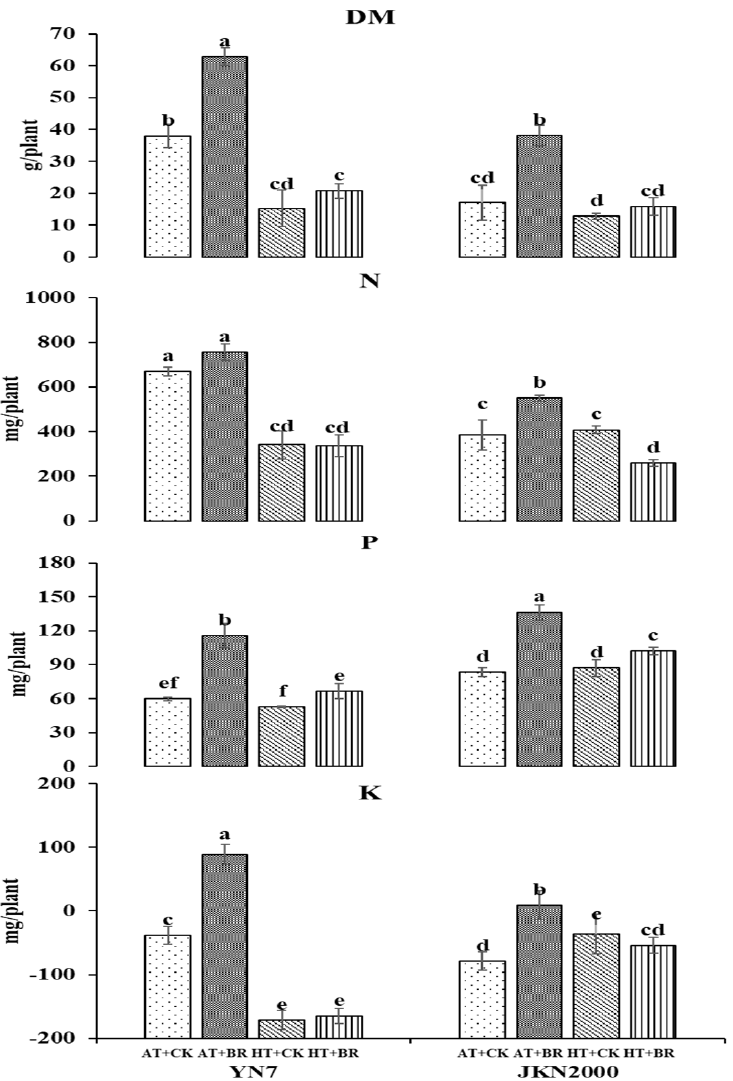
Figure 4. Effects of exogenous BR application at the silking stage on the remobilization of post-silking DM and nutrients of waxy maize under post-silking ambient and high temperatures. YN7, Yunuo7; JKN2000, Jingkenuo2000; AT, ambient temperature; HT, high temperature; CK, control, plants sprayed with 100 mL water; BR, brassinolide, plants sprayed with 100 mL 0.25 mg/L BR. Within columns, those followed by the same letters are not significantly different ( p <